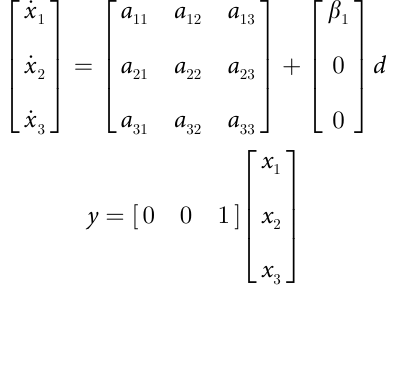
Table 1. Necessary mathematical conditions for adaptation. These mathematical conditions can be translated to structural requirements assuming the monotone property of the underlying autonomous dynamical system. Possibilities Final condition a 21 α cb β 2 < 0 Gross − ve feedback